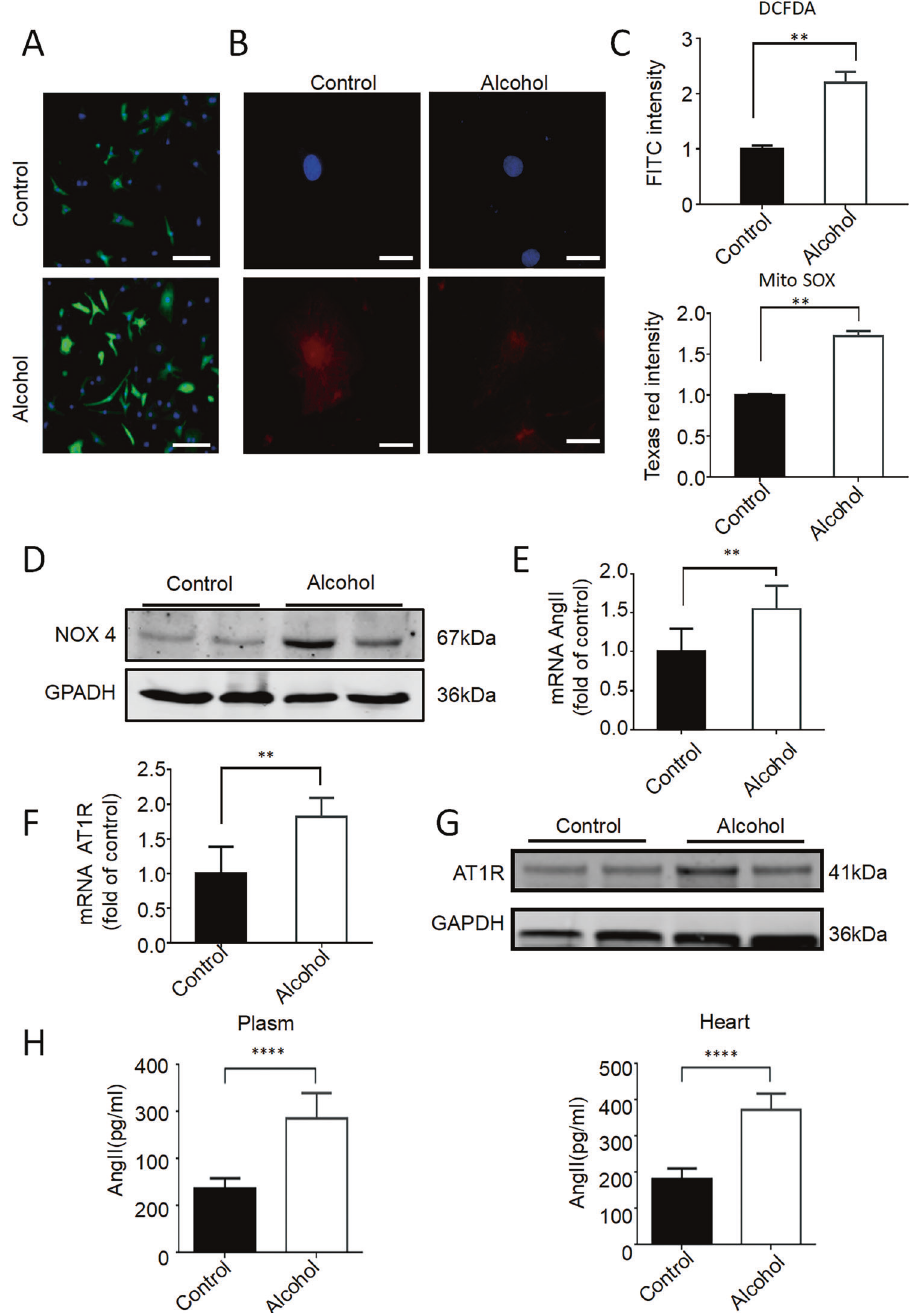
Fig. 4 Alcohol-induced ROS and AngII/AT1R activation in cardiomyocytes. A – C Representative immuno fl uorescence images of CM- H2DCFDA (scale bar = 15 μ m) and Texas red labeling (scale bar = 25 μ m), and quantitative statistics showed that the level of the oxidative stress and mitochondrial oxidative stress signi fi cantly increased after hiPSC-CMs were treated with 100 mM alcohol for 2 h ( n = 10). D Western blot showed that AT1R protein expression increased signi fi cantly after treatment with 100 mM ethanol for 24 h ( n = 5). E RT-PCR showed that the expression of AngII and AT1R expression increased signi fi cantly after treatment with 100 mM alcohol for 24 h ( n = 5). F RT-PCR showed that the expression of AngII and AT1R expression increased signi fi cantly after treatment with 100 mM alcohol for 24 h ( n = 5). G Western blot showed that AT1R protein expression increased signi fi cantly after treatment with 100 mM alcohol for 24 h ( n = 5). H Enzyme-linked immunosorbent assay showed that the level of AngII in the plasma and heart of mice increased after alcohol treatment ( n = 6). Results are presented as means ± SEM (** P < 0.01; two-sided Student ’ s t -test or one-way analysis of variance).